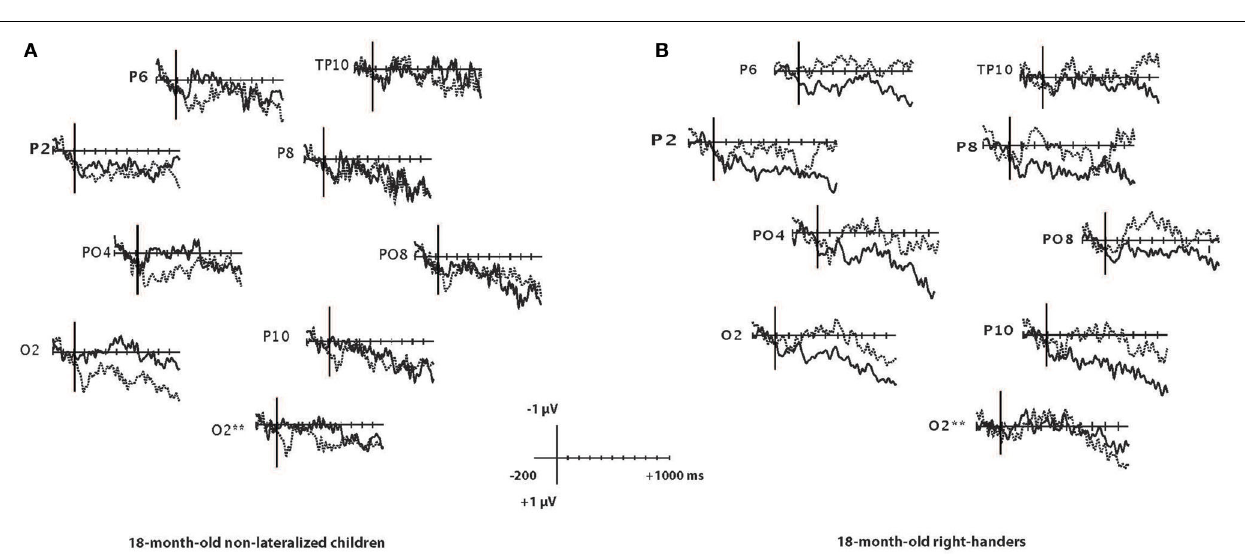
FIGURE 2 | (A,B) Grand-averaged waveforms for related (solid line) and unrelated (dashed line) target words in 18-month-old right handers (A) and non-lateralized (B) children over the right parietal-occipital recording sites.